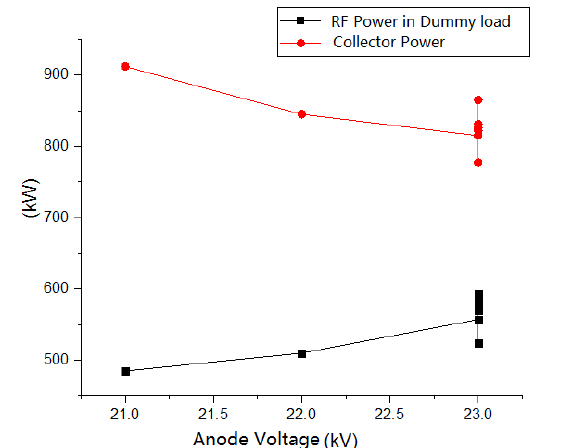
Fig. 8. Changes in the output power of the gyrotron when the magnetic field current, filament primary voltage, filament primary current, and cathode voltage are 50.55A, 39.7V, 34.7A, and -44kV,